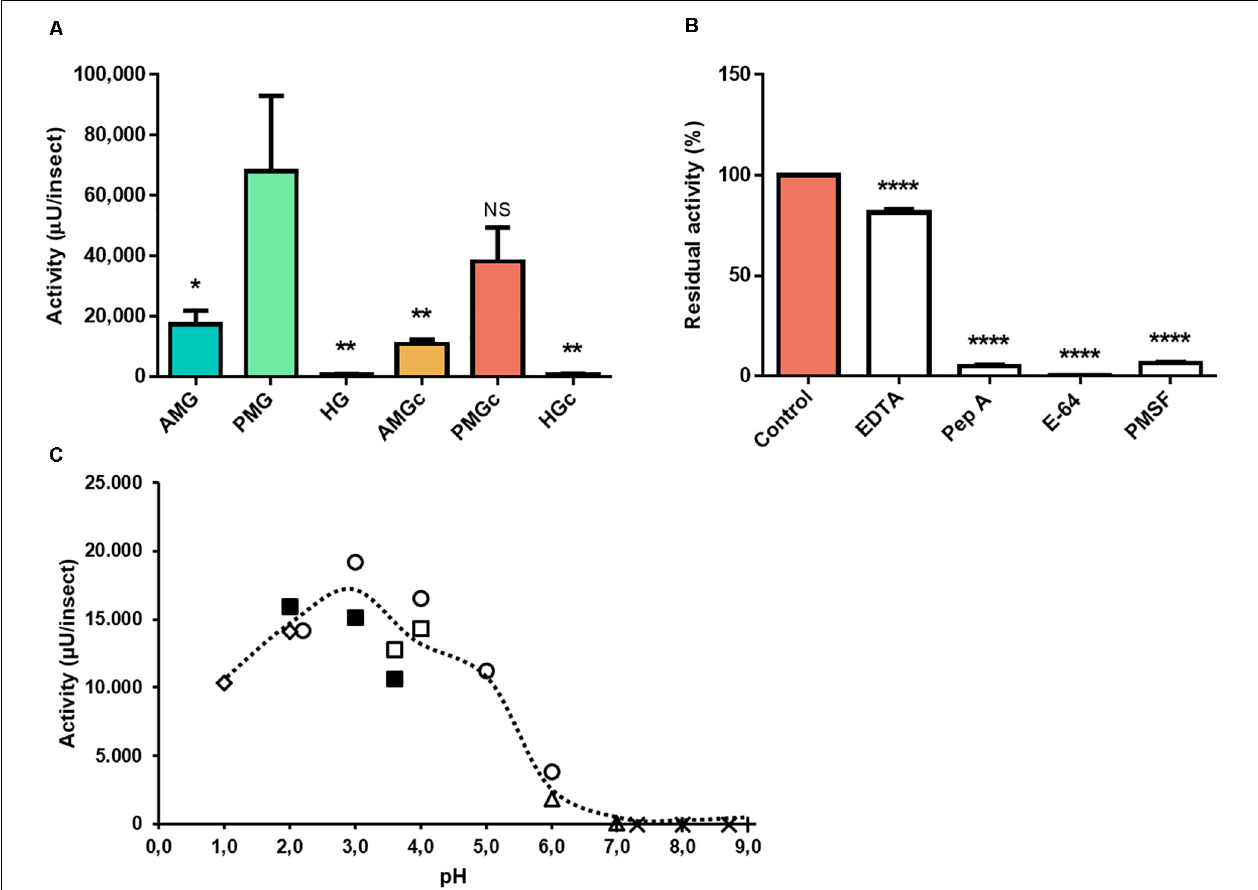
FIGURE 2 | Compartmentalization and characterization of cathepsin D activity in the digestive tract compartments of male adult Rhodnius prolixus . (A) Comparison of protease activity between homogenates of the anterior midgut (AMG), posterior midgut (PMG), and hindgut (HG) tissues and their respective luminal contents, assayed in 0.2 M glycine-HCl, pH 3.6. (B) Effects of the protease inhibitors EDTA (1 mM), pepstatin A (1 µ M), E-64 (10 µ M), and PMSF (1 mM) on the proteolytic activity of PMG contents, assayed in 0.2 M glycine-HCl, pH 3.6. (C) Effects of the pH variation on the proteolytic activity of PMG content samples, using the buffers KCl, pH 1.0 and 2.0 ( ♦ ); glycine-HCl, pH 2.0, 3.0, and 3.6 ( (cid:4) ); sodium acetate, pH 3.6 and 4.0 ( (cid:3) ); citrate-phosphate, pH 2.2, 3.0, 4.0, 5.0, and 6.0